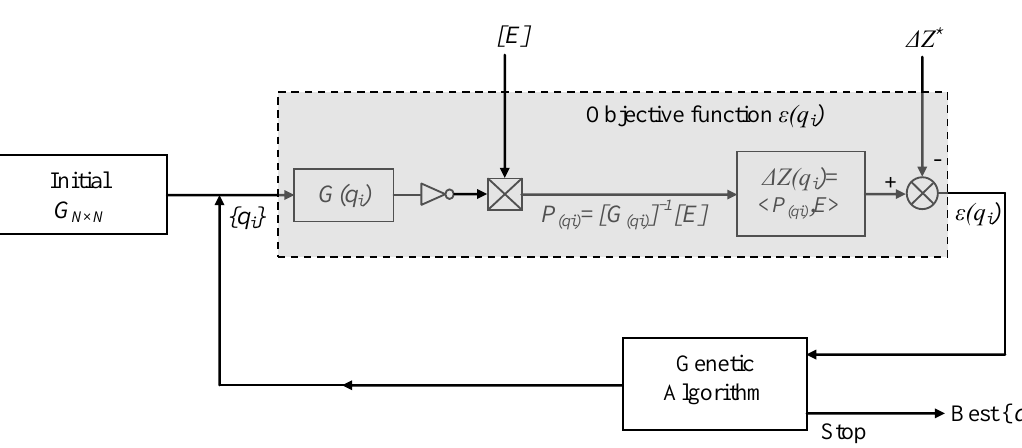
Figure 7. The inversion flow chart.